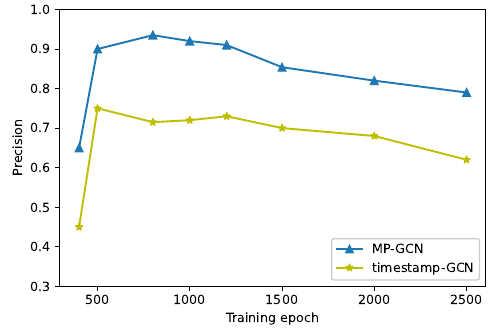
Figure 9. Impact of training